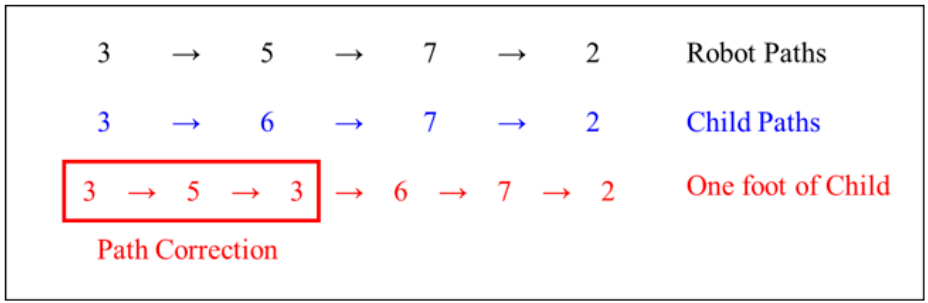
Figure 8. Indicator B4_2 (incorrect path before correct path).